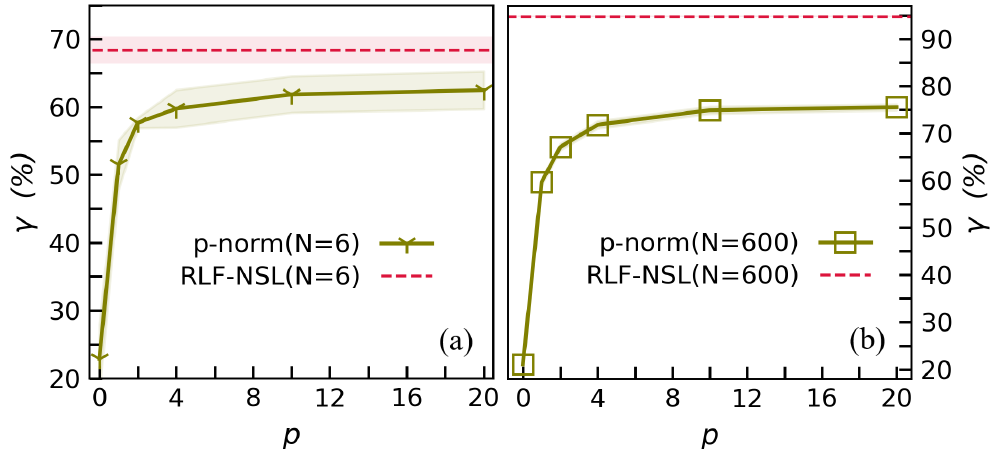
Figure A1. The classification accuracy γ on the MNIST dataset for ( a ) N = 6 and ( b ) N = 600. The solid line with symbols show the results by using p-norm as the kernel in the NSL algorithm. The horizontal dash lines show the accuracies of the RLF-NSL with β = 1.08 and 1.35, respectively. The shadows demonstrate the standard